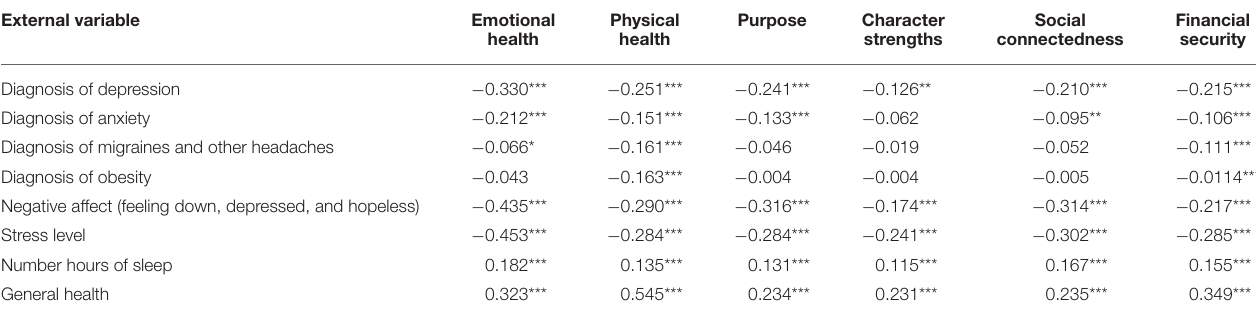
TABLE 6 | Correlations of WBA domains with external variables.